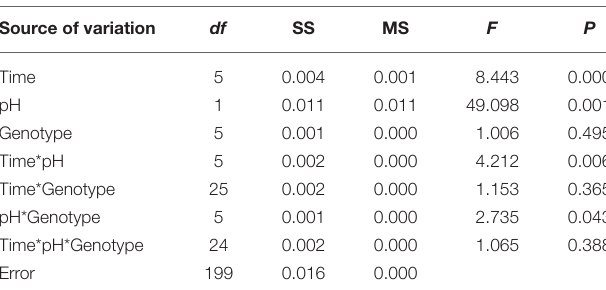
TABLE 5 | Long-term experiment three-way factorial ANOVA with calcification as the dependent variable showing the effect of time, pH treatment, and genotype.